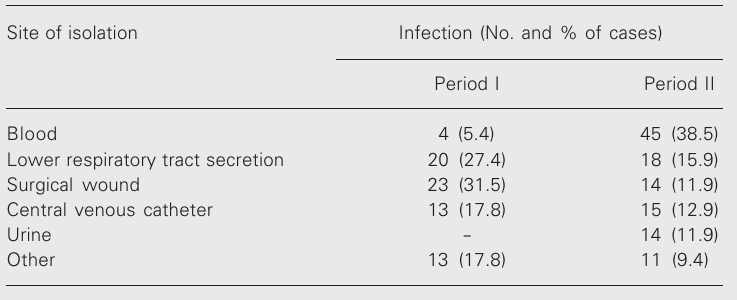
Table 1. Sites of isolation of methicillin-resistant Staphylococcus aureus (MRSA) infection in patients hospitalized in a University Hospital. Site of